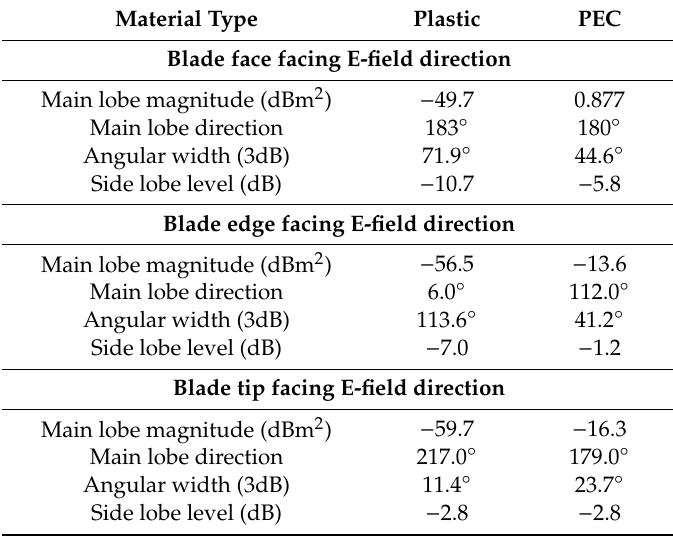
Table 4. Cartesian and Polar summary of values for plastic and PEC materials.